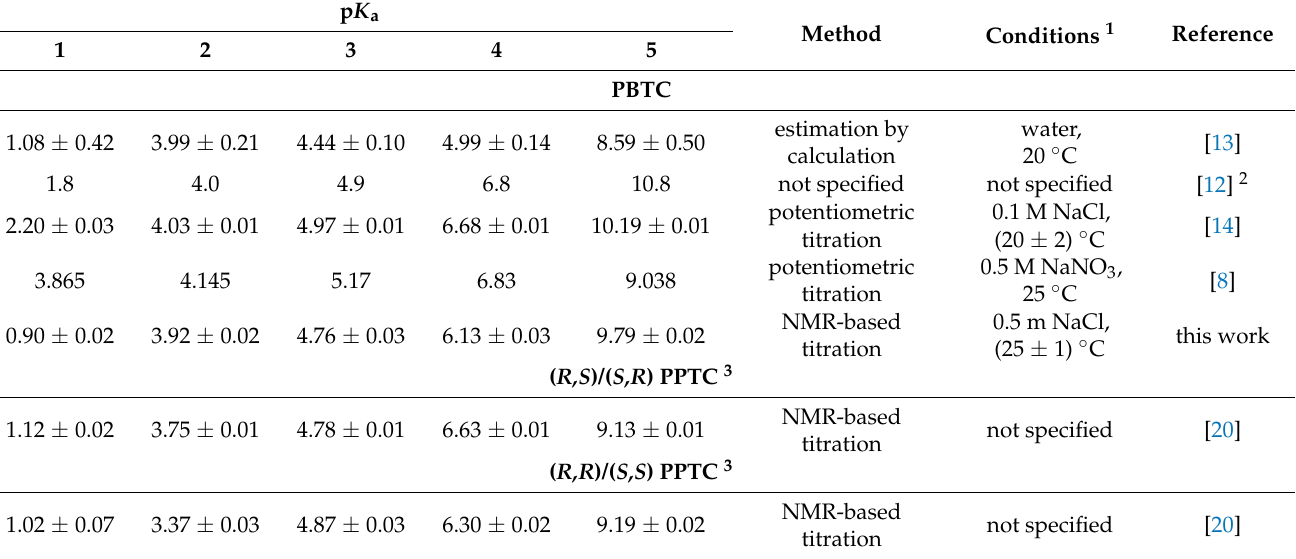
Table 1. Overview and comparison of PBTC p K a values along with method and conditions. p K